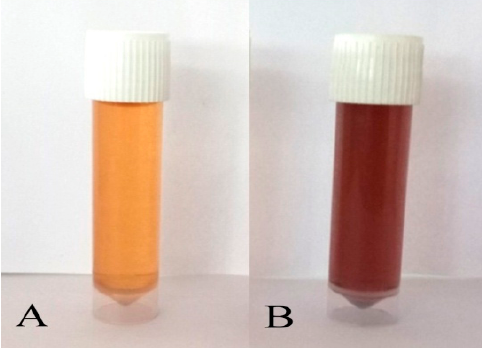
Figure 2. Biosynthesis of P-AgNPs from leaf extract of P. alba : mixture of aqueous Plumeria alba leaf extract and AgNO 3 solution ( A ) before incubation and ( B ) after incubation.